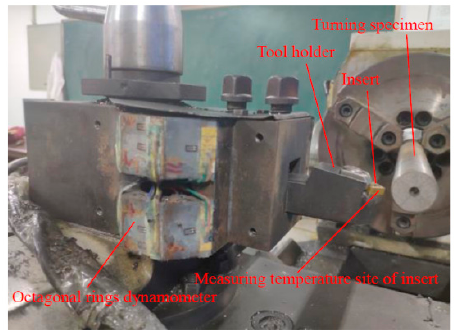
Figure 3. Cutting tool and octagonal ring dynamometer installation.